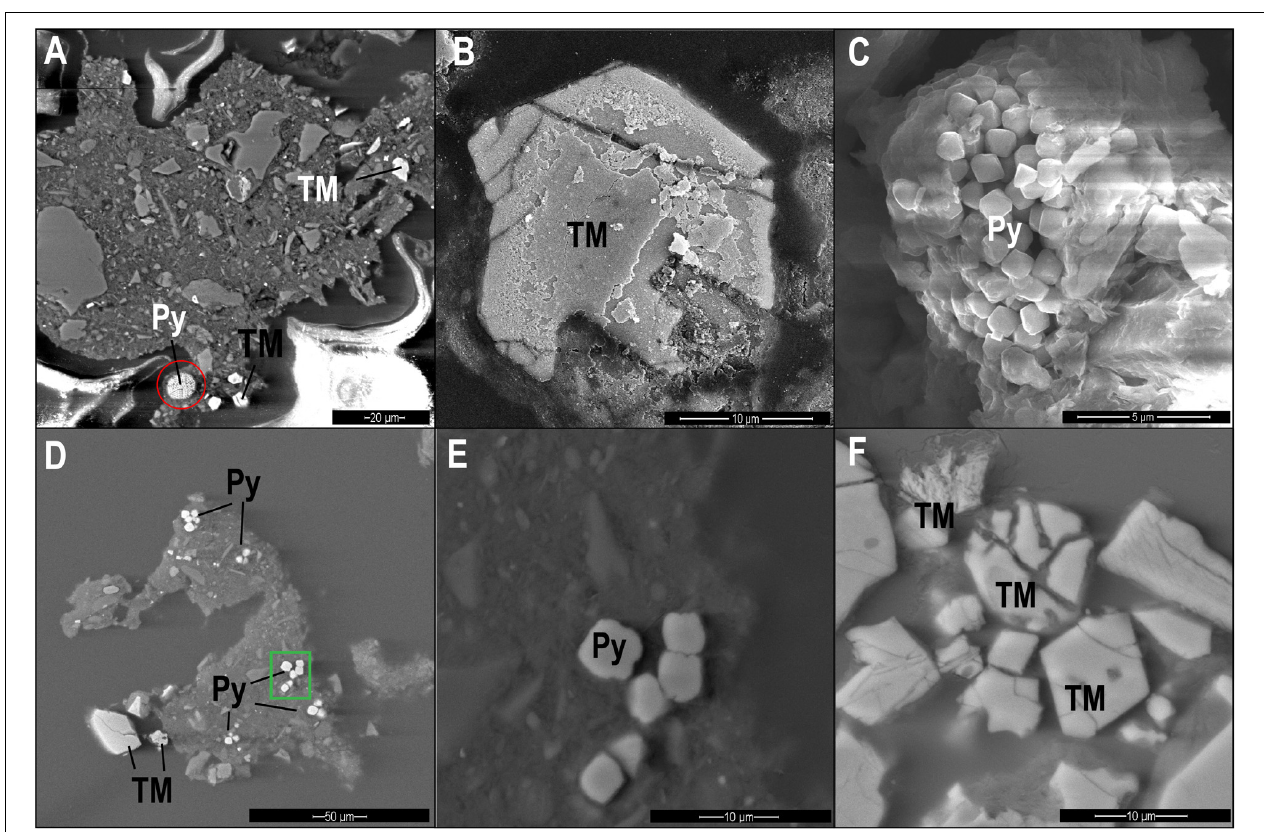
FIGURE 7 | SEM images of pyrite (Py) and titanomagnetite (TM) particles from different diagenetic zones. (A) Backscattered electron (BSE) image of pyrite framboid (red circle) and titanomagnetite from Zone I (84 cm depth). (B) Secondary electron (SE) image of titanomagnetite with dissolution marks from Zone II (160 cm). (C) SE image of a pyrite framboid from Zone II (160 cm). (D,E) BSE image of pyrite and titanomagnetite particles from Zone III (280 cm). (E) is an enlarged picture of the pyrite region marked with green frame. (F) BSE image of partly dissolved titanomagnetite from Zone III (280